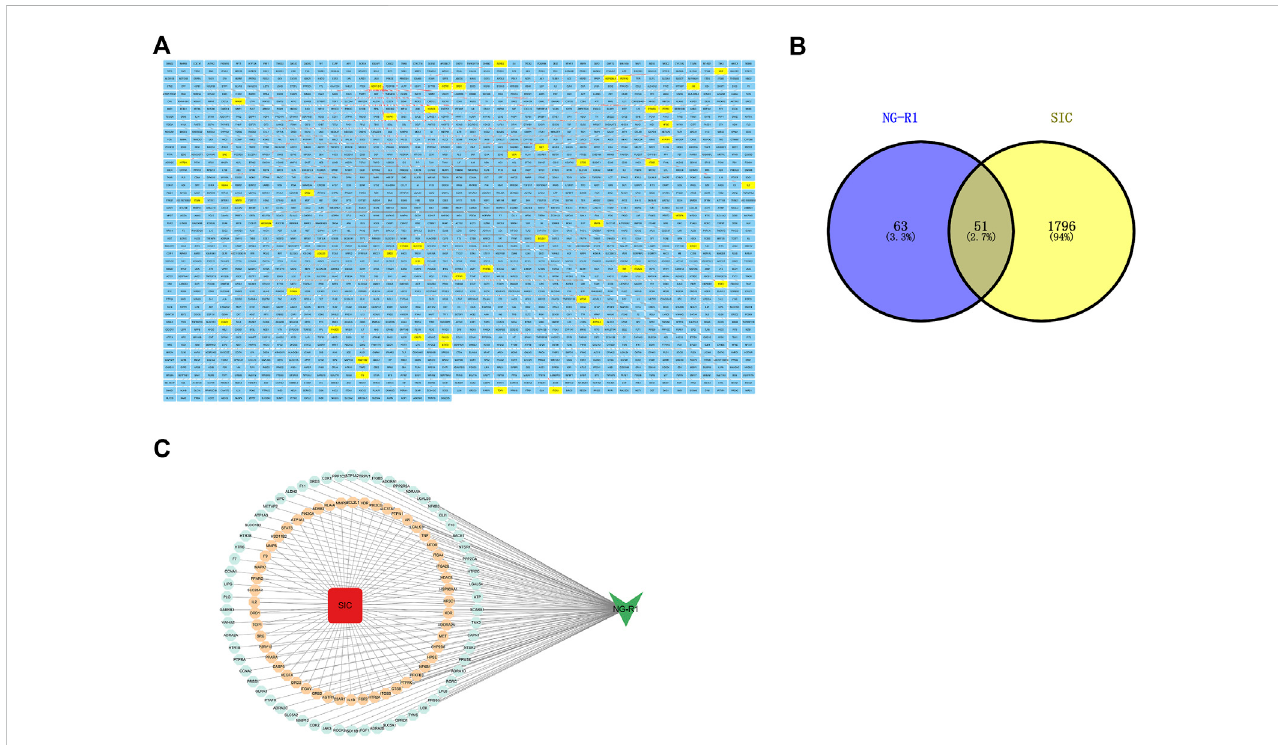
FIGURE 3 Target screening. (A) NG-R1 and SIC target summary, with NGR1-SIC common targets highlighted in yellow. (B) Venn analysis of NG-R1 and SIC crossover targets. (C) Data visualization of NG-R1 and SIC-related